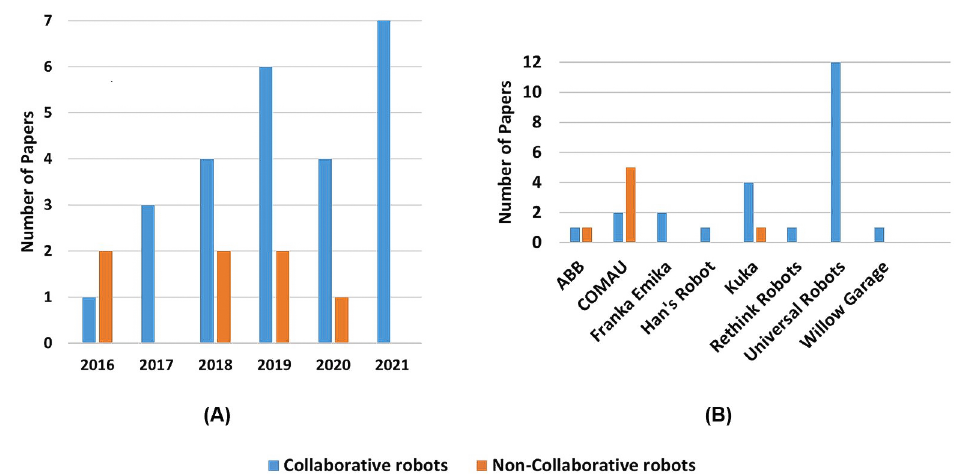
Figure 15. ( A ) Type of robots per year; ( B ) papers by robot